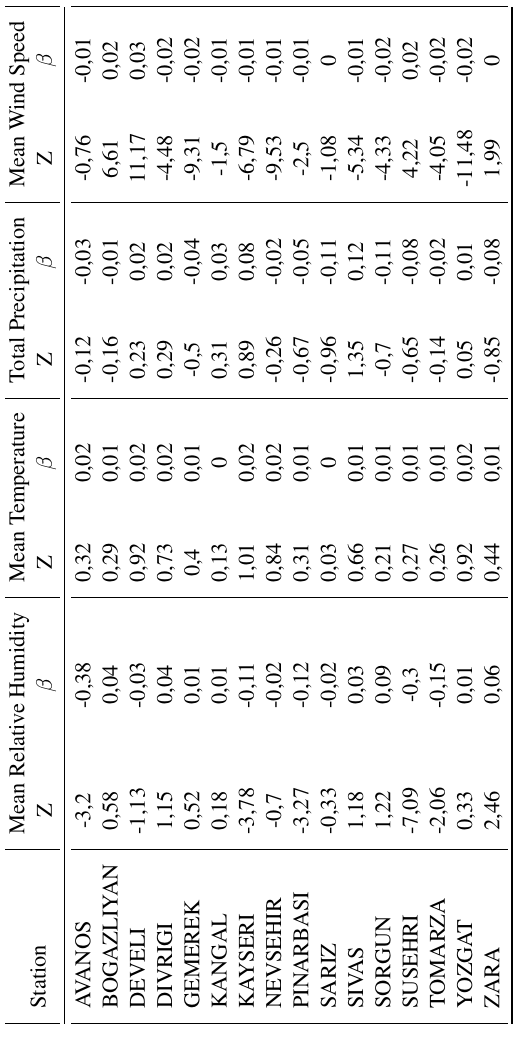
Table 2. Calculated trend analysis results (Z is Mann Kendall statistical test results and β is Theil Sen Slope